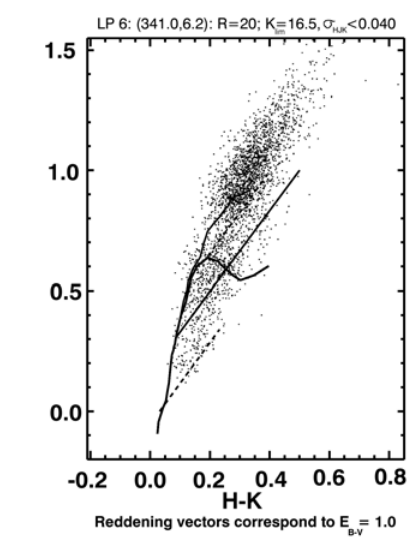
Fig. 1. 2MASS data within 20 (cid:2) from Lupus 6 center. Standard se- quences from Bessell & Brett (1988). Dotted lines are reddening lines of a length equivalent to E B − V